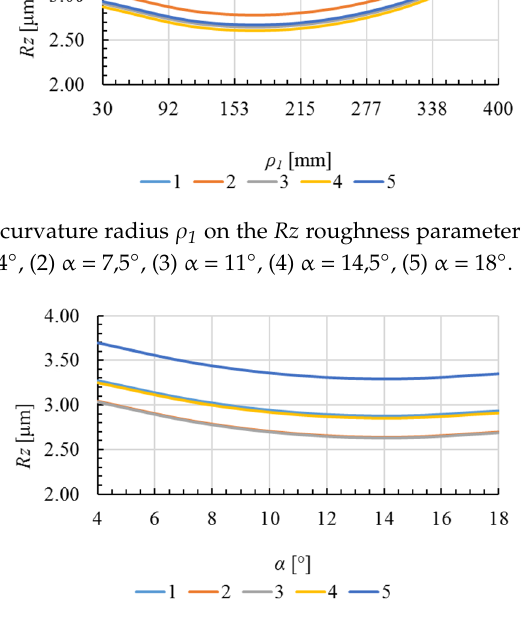
Figure 17. Effect of the lead angle α on the Rz roughness parameter in the machining of the convex surface: (1) ρ 1 = 30 mm, (2) ρ 1 = 122.5 mm, (3) ρ 1 = 215 mm, (4) ρ 1 = 307.5 mm, (5) ρ 1 = 400 mm.